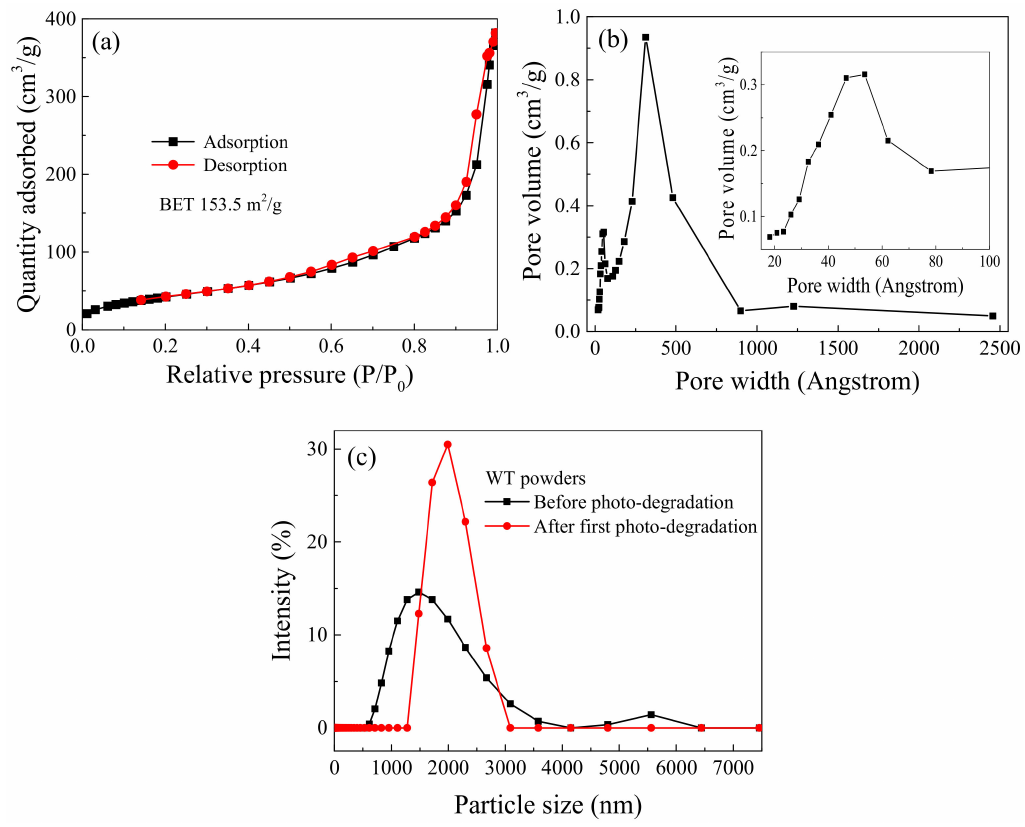
Figure 3. Nitrogen adsorption–desorption isotherms ( a ), pore size distribution curve ( b ) of the WT powders; the particle size distribution curves ( c ) of the WT powders before and after one photodegradation